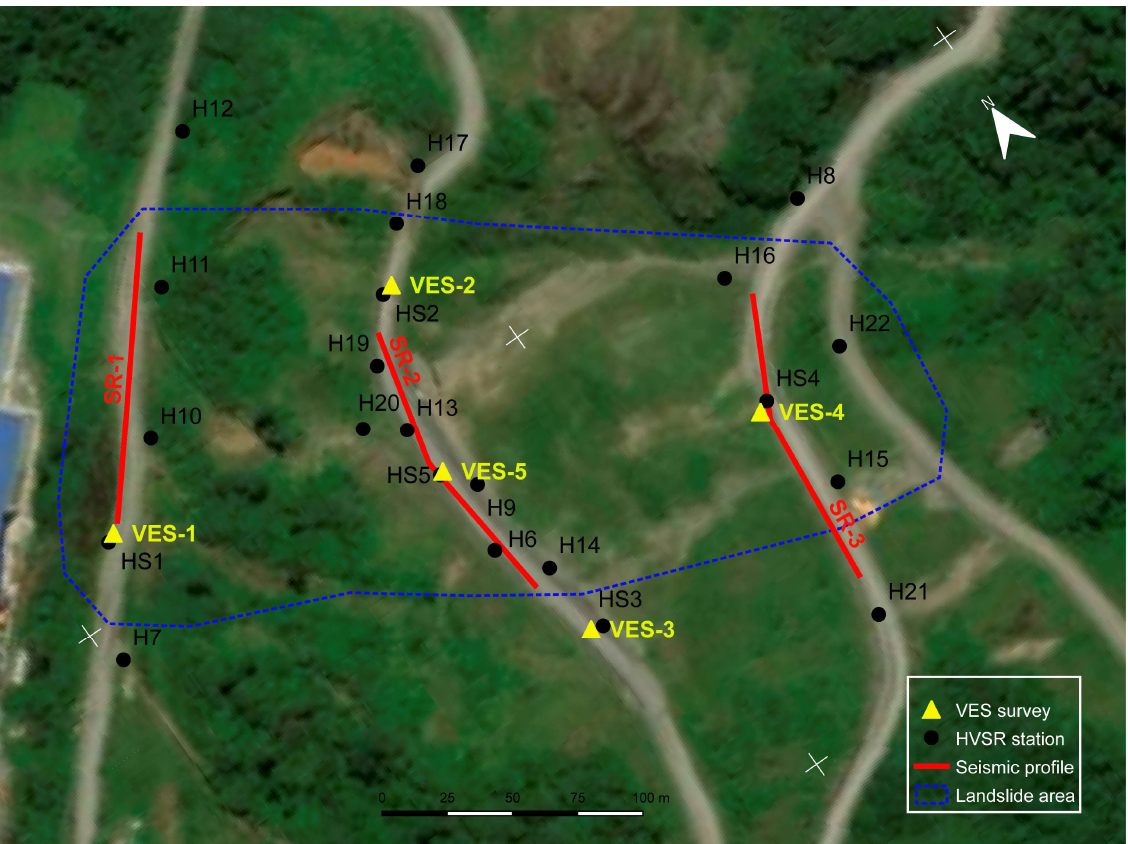
Figure 4. Situation map of surveys (noted that the north is rotated counterclockwise) and observed landslide area (blue dashed line). Black dots: HVSR surveys; yellow triangles: VES surveys; and red lines: seismic refraction and MASW profiles, both made at the same position. White crosses refer to the coordinate points (Modified from [22]).